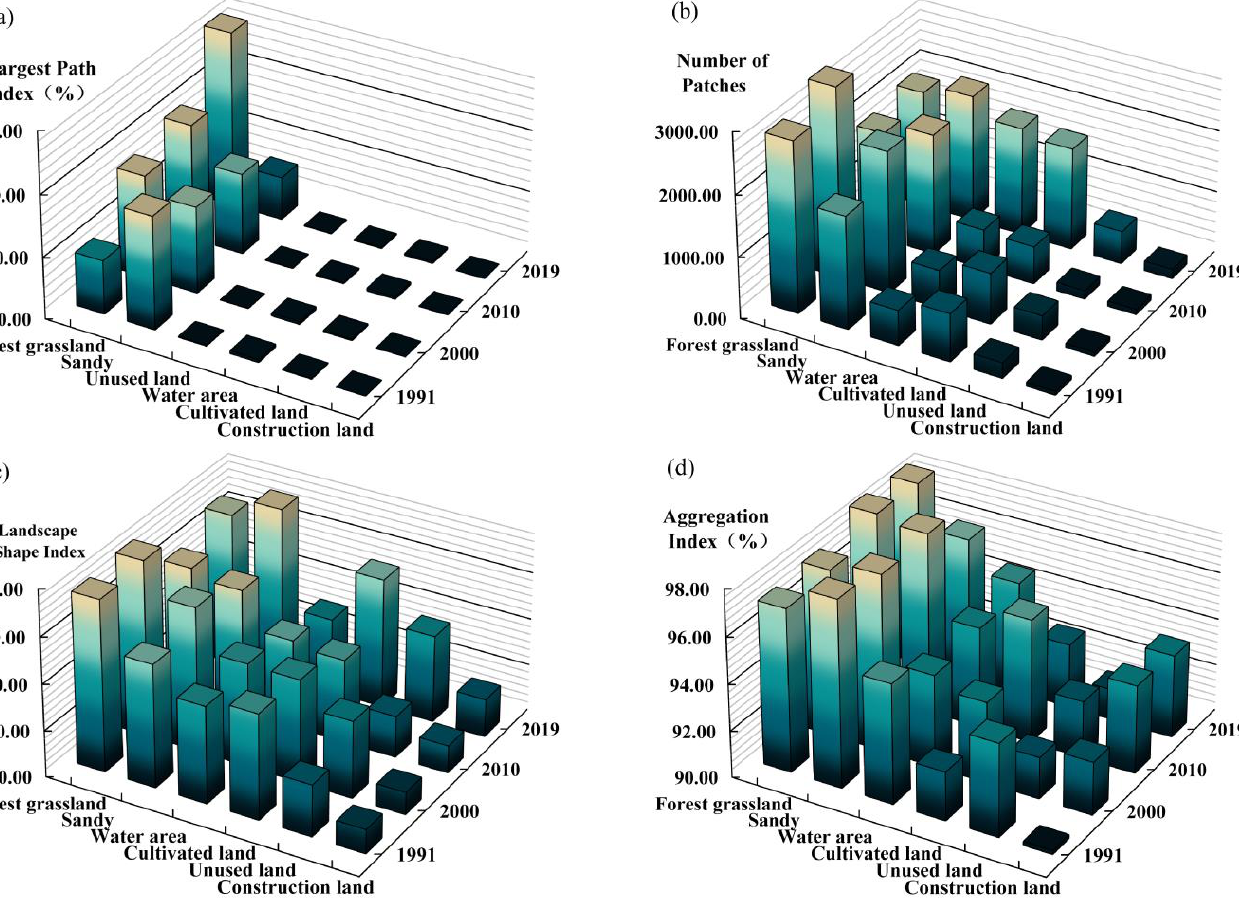
Figure 6. Changes in the landscape indexes at the class scale along the Yellow River section of the Hobq Desert from 1991 to 2019. ( a ) Largest Path Index. ( b ) Number of patches. ( c ) Landscape Shape Index. ( d ) Aggregation Index.